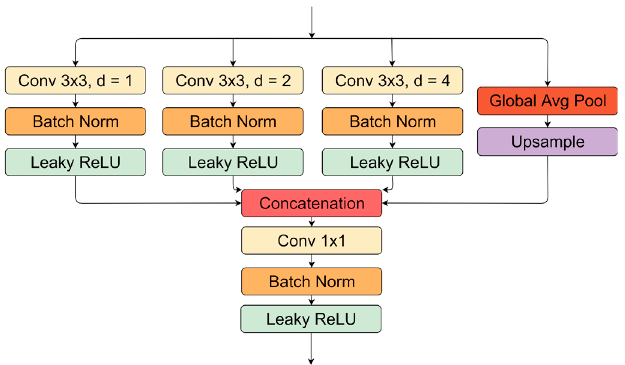
Figure 5. Atrous spatial pyramid pooling module.